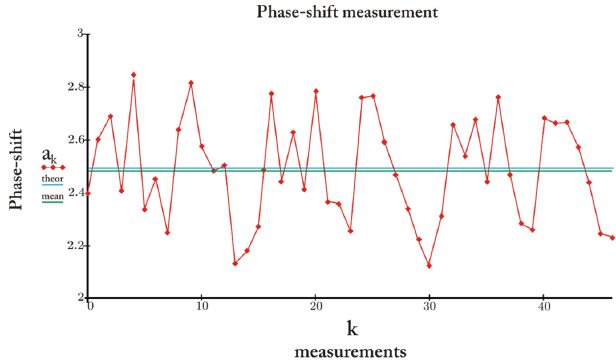
Figure 8. Experimental estimation of error in the phase step.